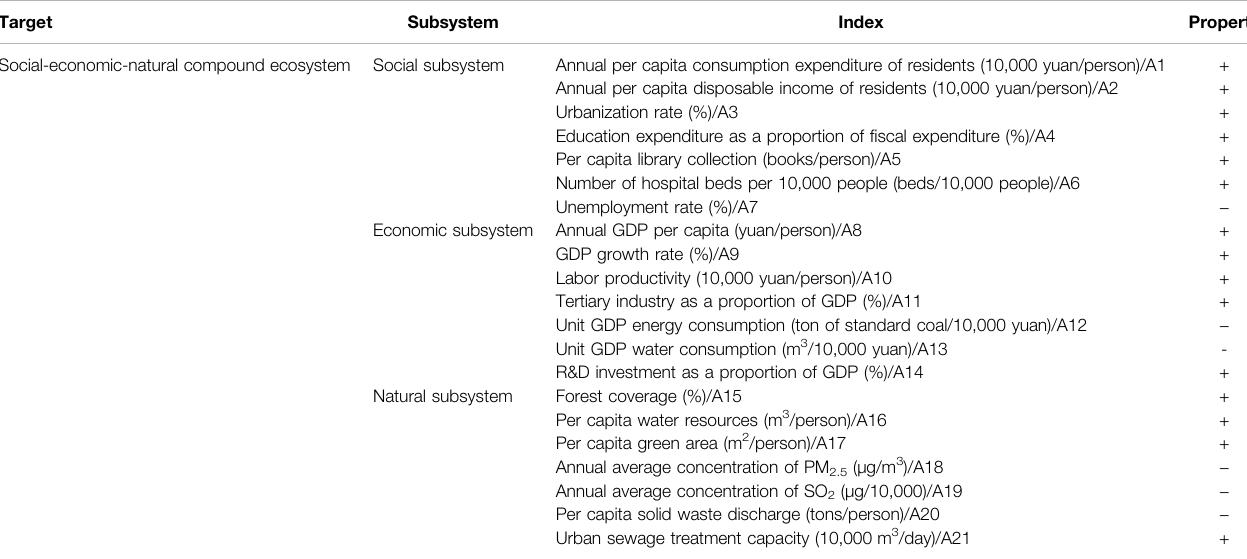
TABLE 2 | Index system for sustainable development of compound ecosystem in the GBA.